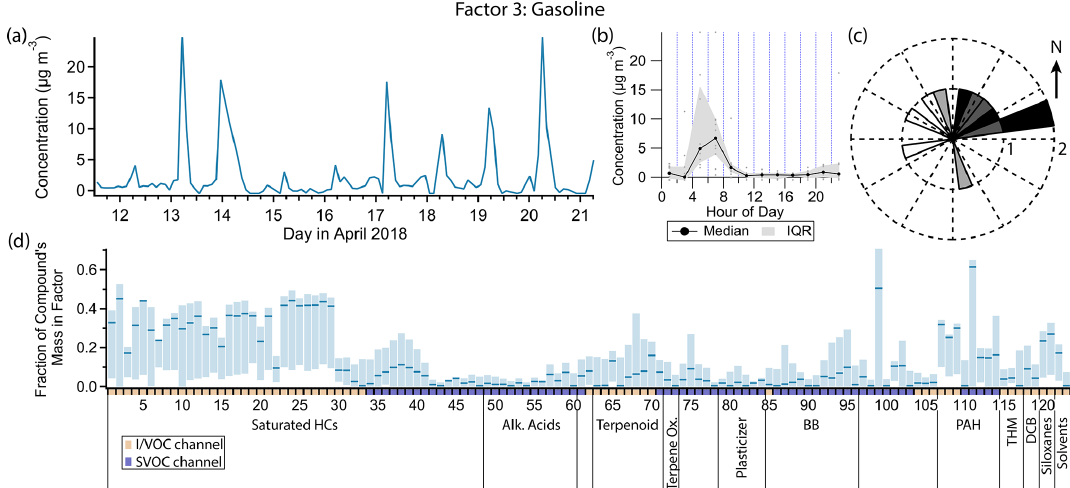
Figure 6. (a) Factor 3 timeline. (b) Diurnal profile for Factor 3. (c) Rose plot showing correlation of elevated emissions and wind direction. (d) Factor 3 composition profile. See Fig. 4 description for further information on how to read this